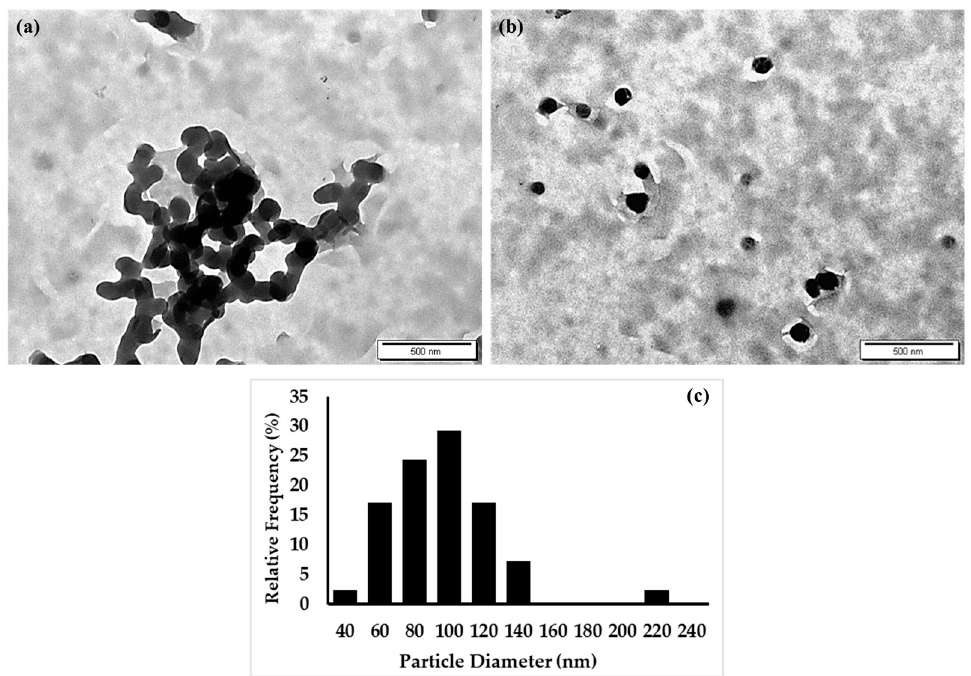
Figure 4. ( a , b ) TEM micrographs of PMZ/Arg-PA NCs highlighting the particle shape and size. Scale bar = 500 nm. ( c ) Histograms of the frequency distribution representing the exact diameters of PMZ/Arg-PA NCs and the corresponding percentages/proportions of each diameter in the sample; the data were generated from TEM images of drug-loaded Arg-PA nanoparticles containing several particles ( n = 40) .